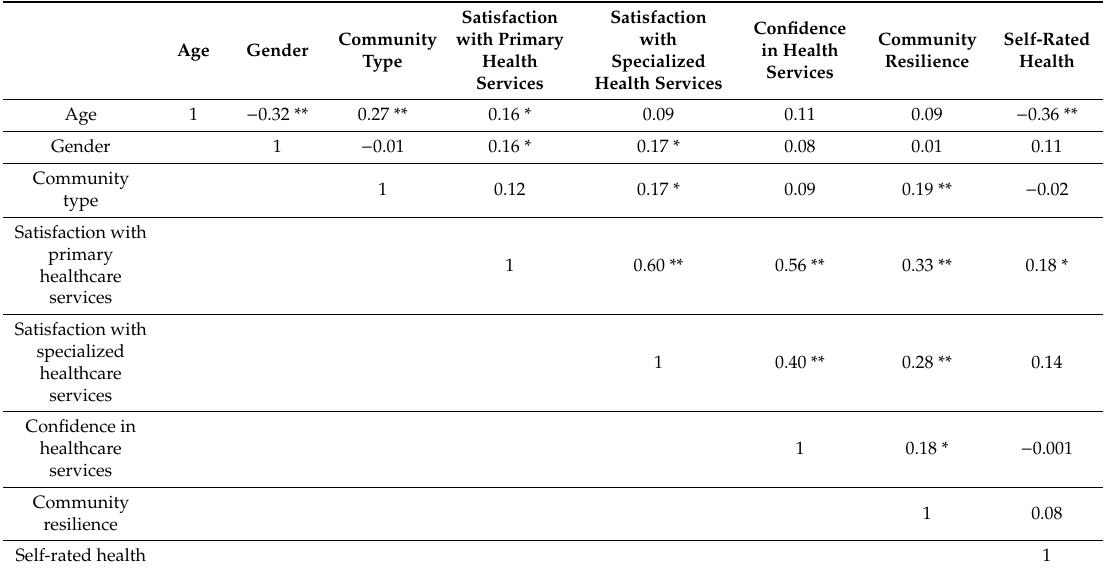
Table 2. Pearson correlations between main research variables ( N = 196).